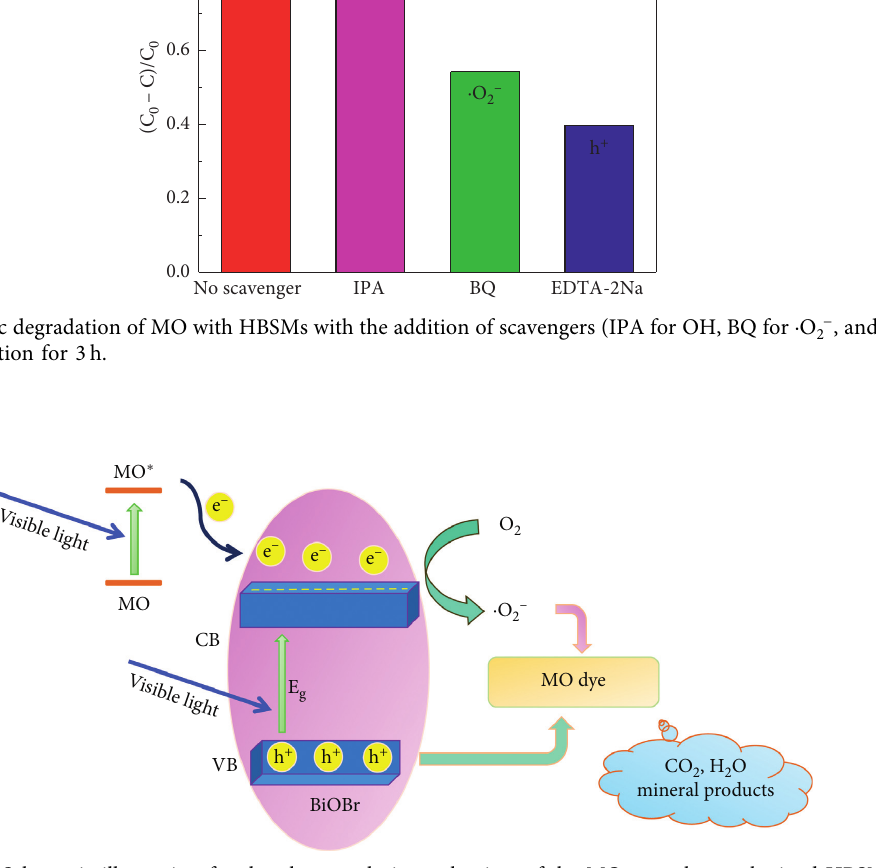
Figure 11: Schematic illustration for the photocatalysis mechanism of the MO over the as-obtained